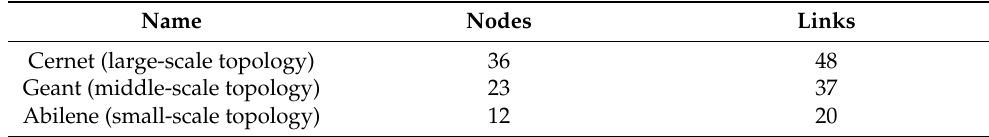
Table 1. Three realistic network topologies. Name Nodes